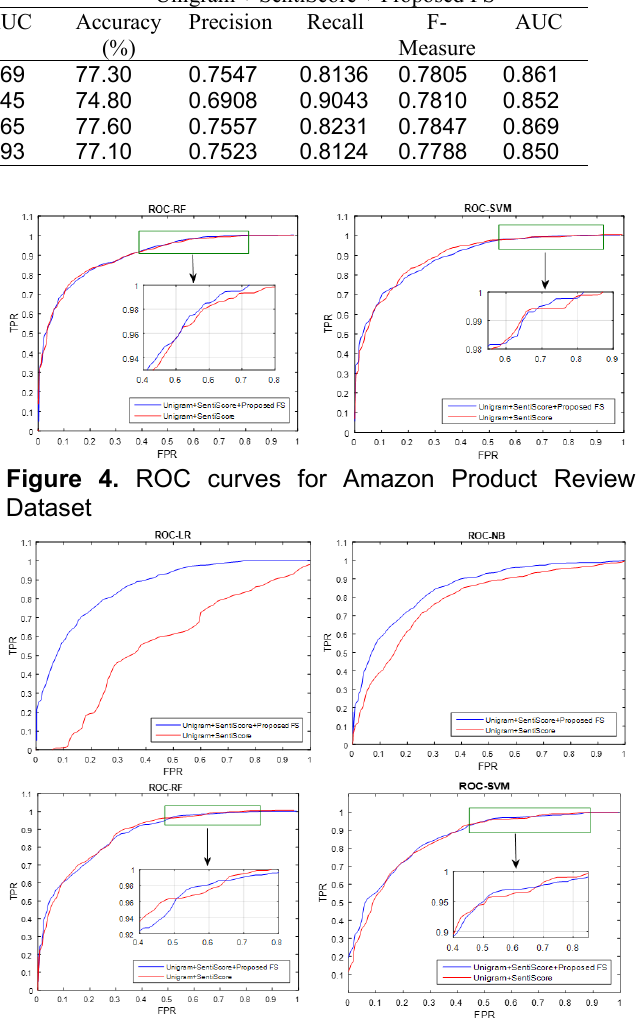
Figure 5. ROC curves for Yelp Restaurant